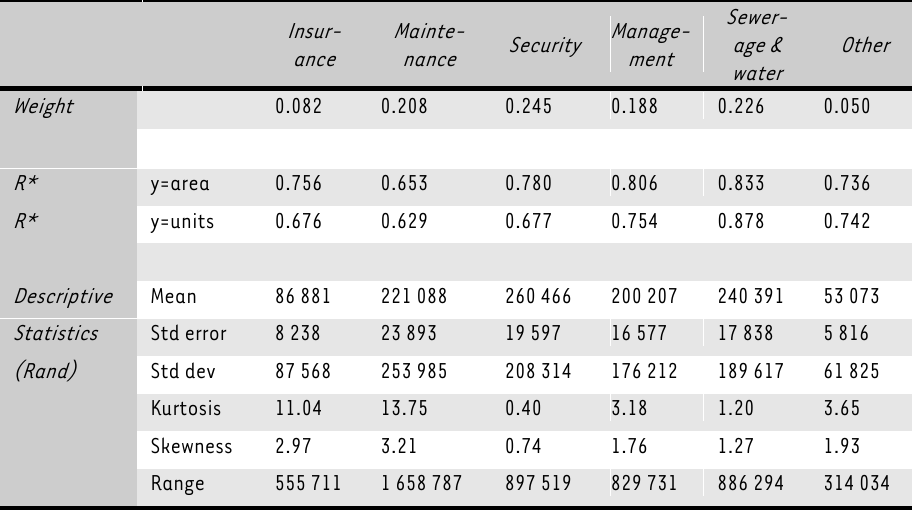
Analysis of the cost data (n = 113)